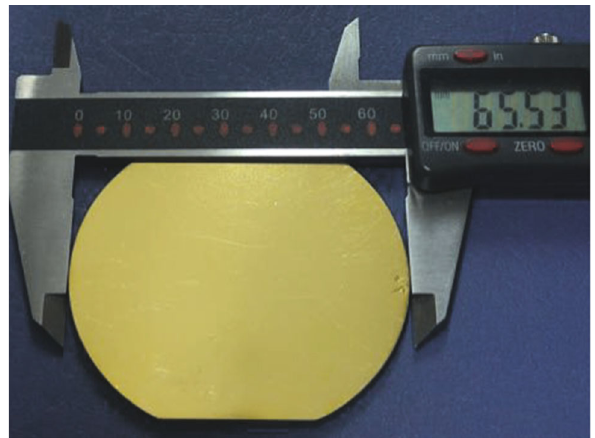
Fig. 8 Doped Ge wafer with a 4000 Å gold deposition. The Au on the two large surface of the wafers serve as Ohmic contacts for reading-out the sensor